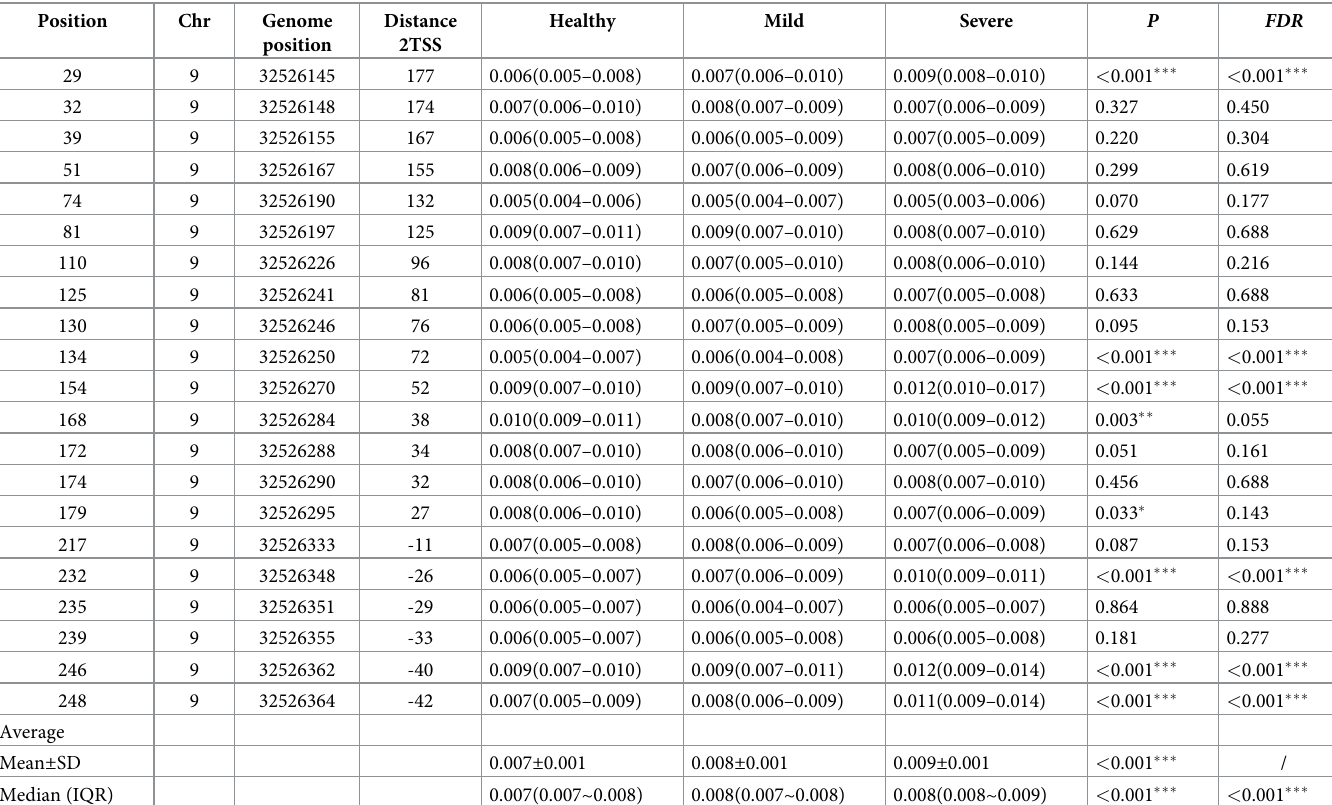
Table 1. Details of the CpG regions in the CpG islands of